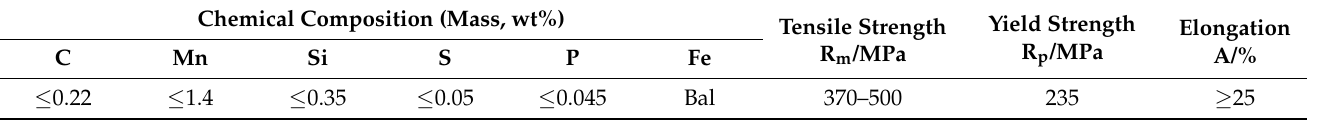
Table 2. The normative reference of Q235